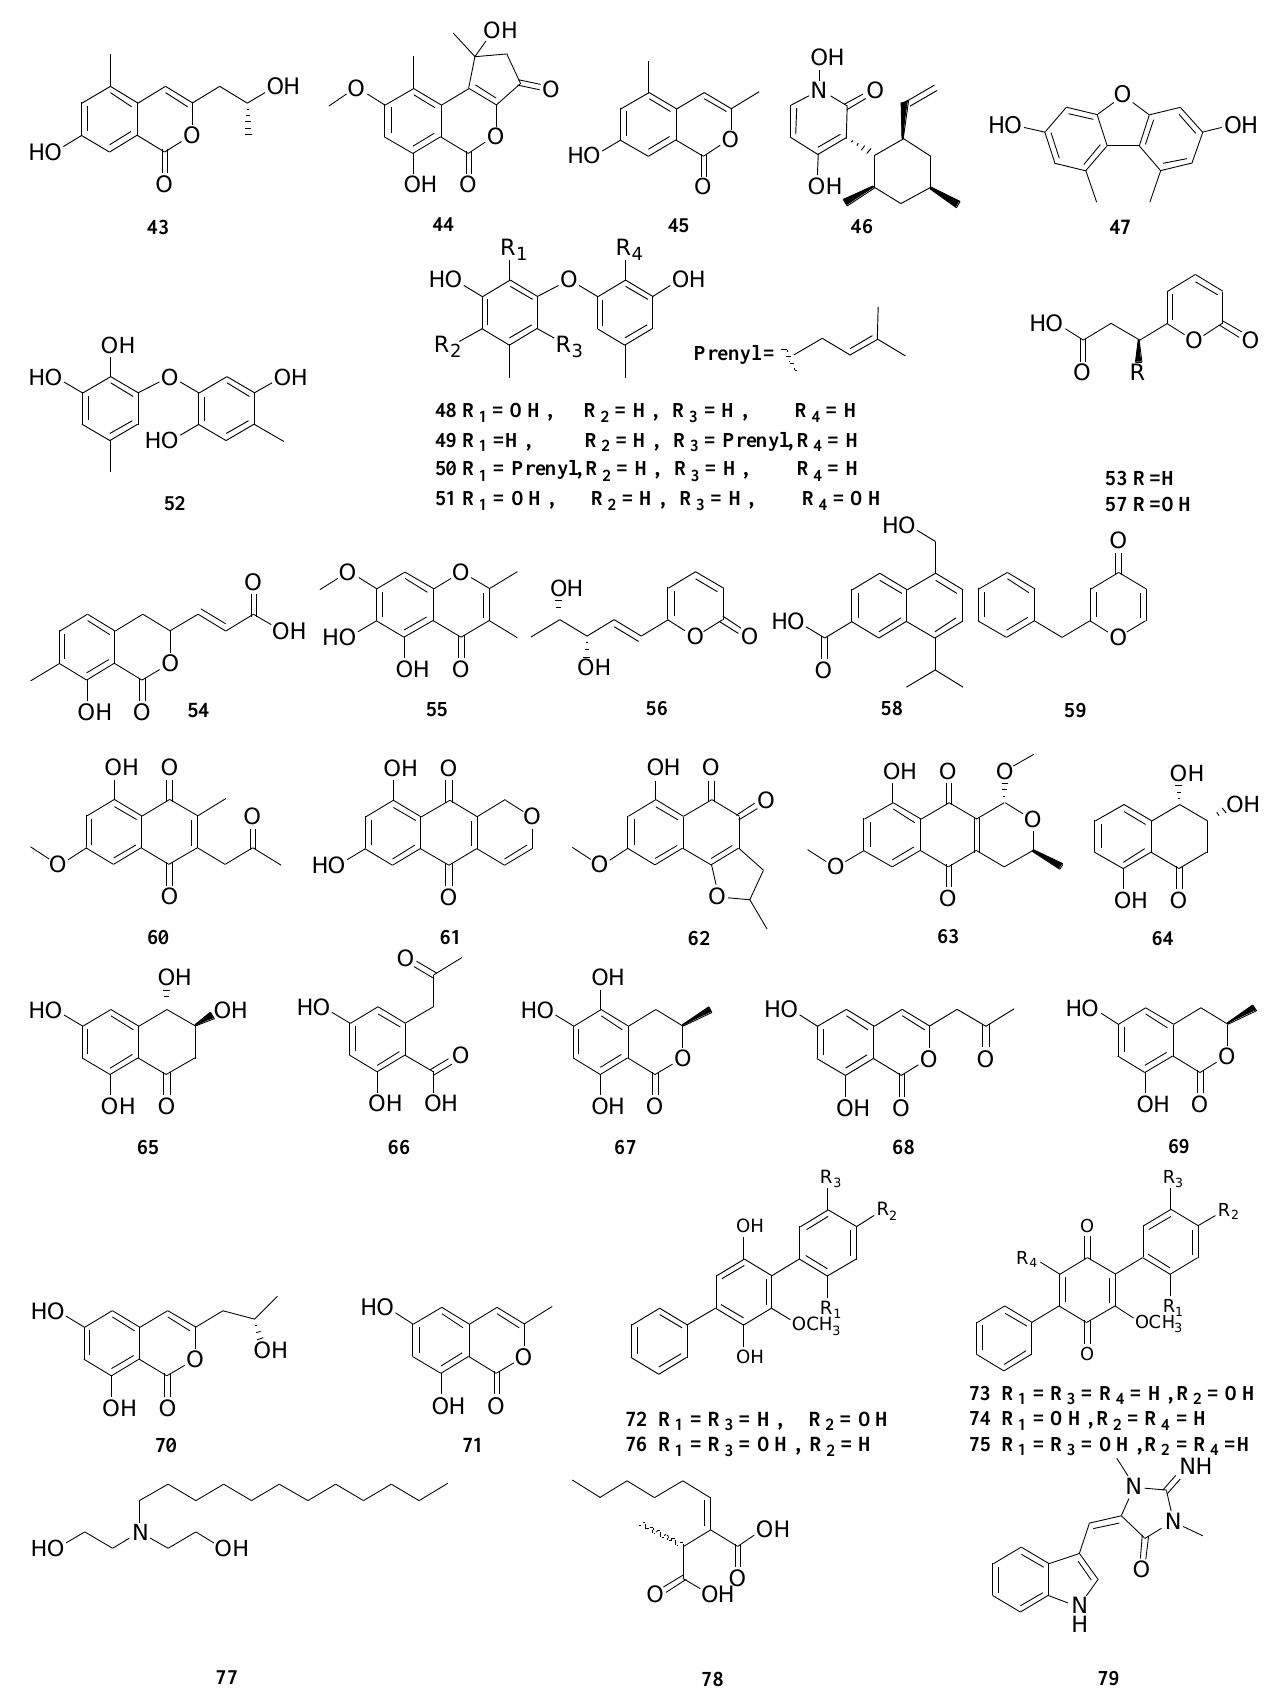
Figure 1. Structures of the antimicrobial compounds isolated from ELF.